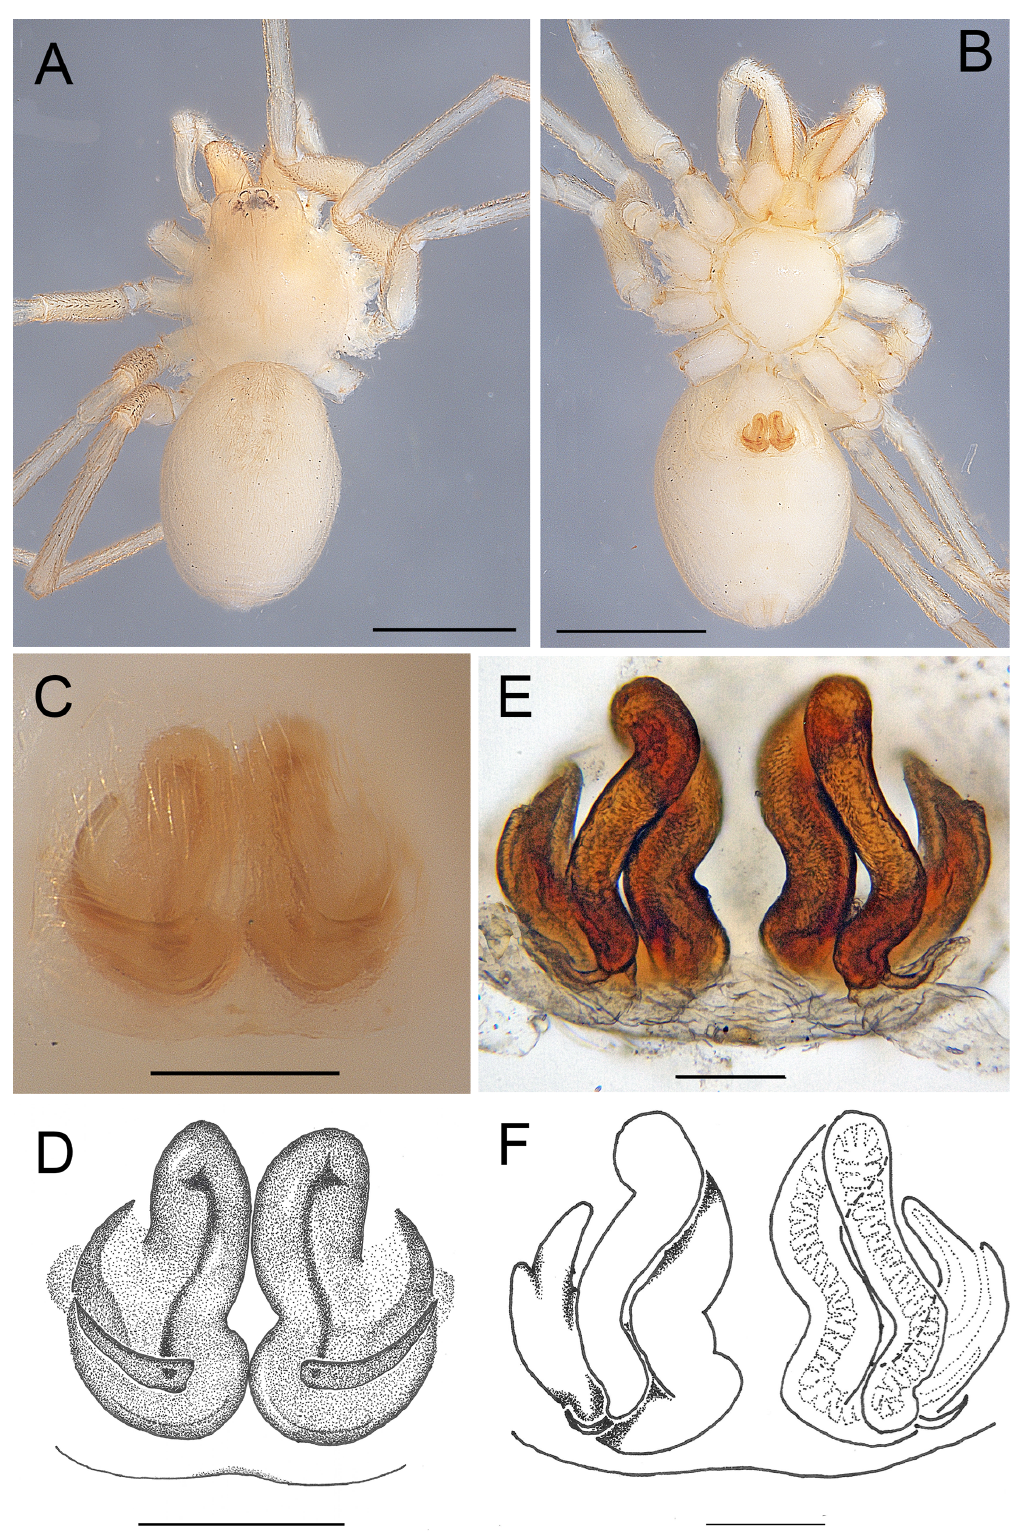
Fig. 16. Andromma delphiurum sp. nov., ♀, paratype (BE_RMCA_ARA.Ara 247537). A . Habitus, dorsal view. B . Same, ventral view. C–D . Epigyne, ventral view. E–F . Same, cleared, dorsal view. Scale bars: A–B = 1 mm; C–D = 0.2 mm; E–F = 0.1